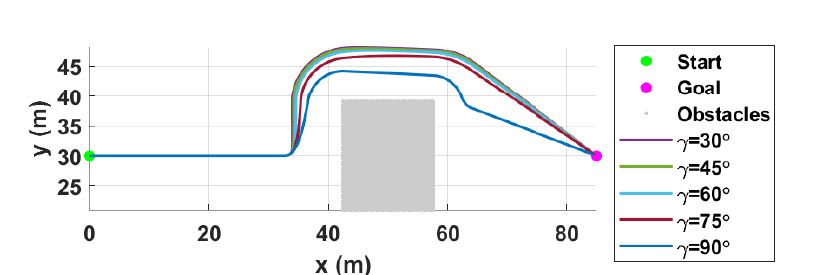
Figure 4. 2D trajectories in accordance with γ